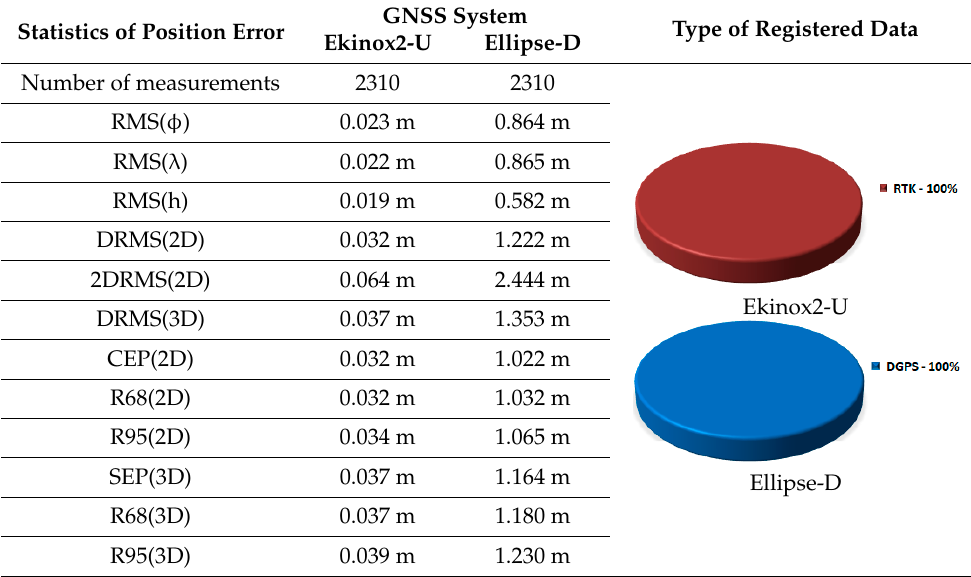
Figure 8. Variability of the 1D, 2D and 3D position errors recorded using the Ekinox2-U system in the RTK mode on route no. 1. As regards the Ellipse-D system, it should be stated that the variability of the 1D, 2D and 3D position errors is low along the entirety of route no. 1 (Figure 9). They fall within the following ranges: 0.482–0.657 m (for the 1D position error), 0.972–1.070 m (for the 2D position error) and 1.093–1.236 m (for the 3D position